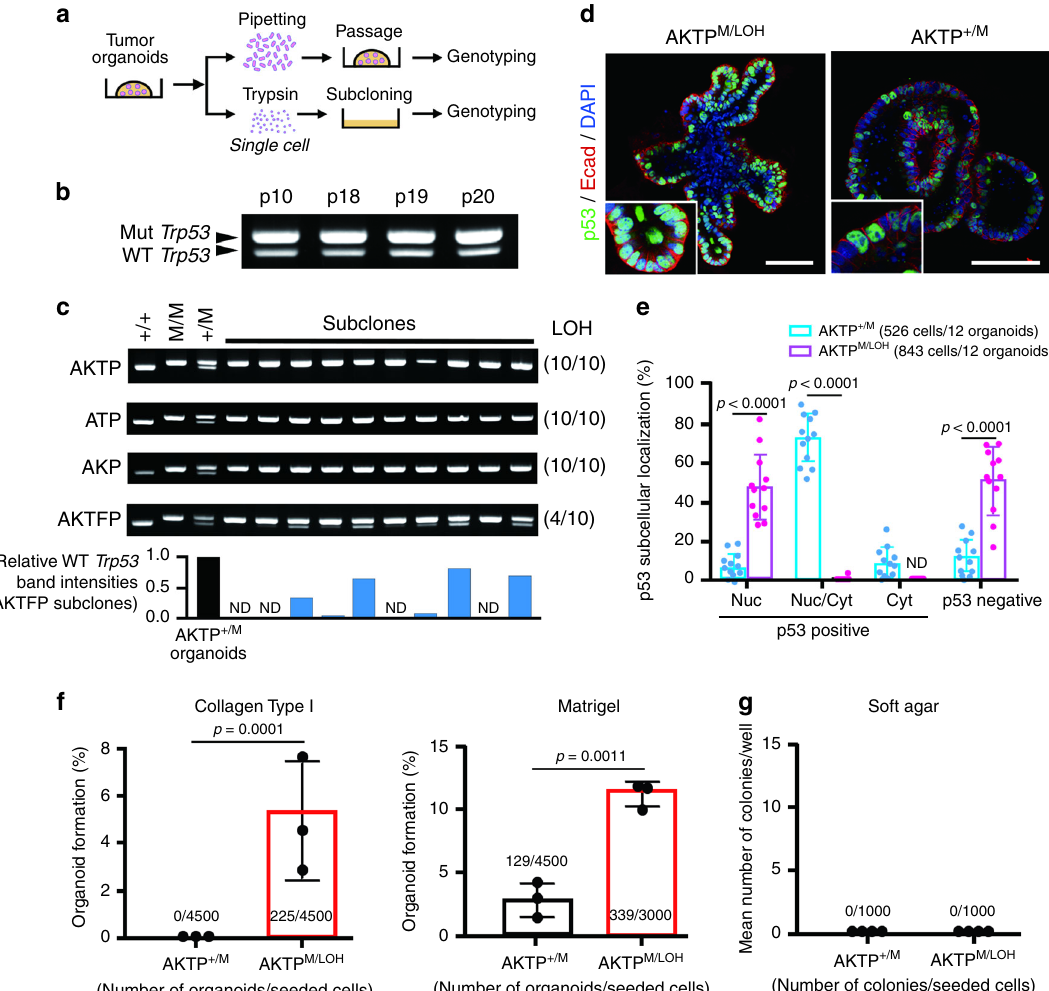
Fig. 2 Selection of Trp53 LOH cells in the subcloned intestinal tumor cells. a Schematic drawing of the Trp53 LOH analysis. The organoids were mechanically dissociated by pipetting and passaged into Matrigel or were enzymatically dissociated to single cells and subcloned on culture dishes. b Representative genomic PCR results of Trp53 of AKTP + /M organoids maintained in Matrigel with mechanical passage (p, passage number). Mut Trp53 and WT Trp53 indicate mutant Trp53 R270H and wild-type Trp53 , respectively. Molecular weight marker for Trp53 allele-speci fi c PCR is shown in Fig. 1d. The experiments shown in ( b ) were repeated three times with similar results, and the representative results are shown. c Genomic PCR results of Trp53 of independent subclones from AKTP + /M , ATP + /M , AKP + /M , and AKTFP + /M organoids. Genomic DNAs of AKTP + / + , AKTP M/M , and AKTP + /M cells were used as controls. The numbers of Trp53 LOH subclones per total subclones are indicated in parentheses. The band intensities (WT Trp53 /Mut Trp53 ) of AKTPF subclones were quanti fi ed using ImageJ, and relative band intensities of each subclone (blue bars) to that of control (closed bar) are indicated as bar graph ( n = 1 for each bar corresponding to each band) (bottom). ND, not detected. d Representative confocal images of AKTP M/LOH (left)